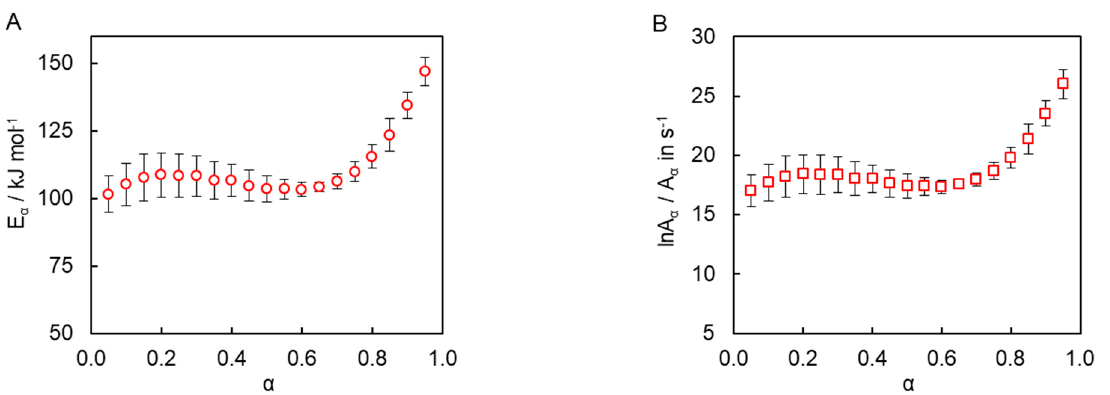
Figure 7. Dependencies of activation energy ( A ) and pre-exponential factor ( B ) as a function of conversion for polymerization of cyanate ester.